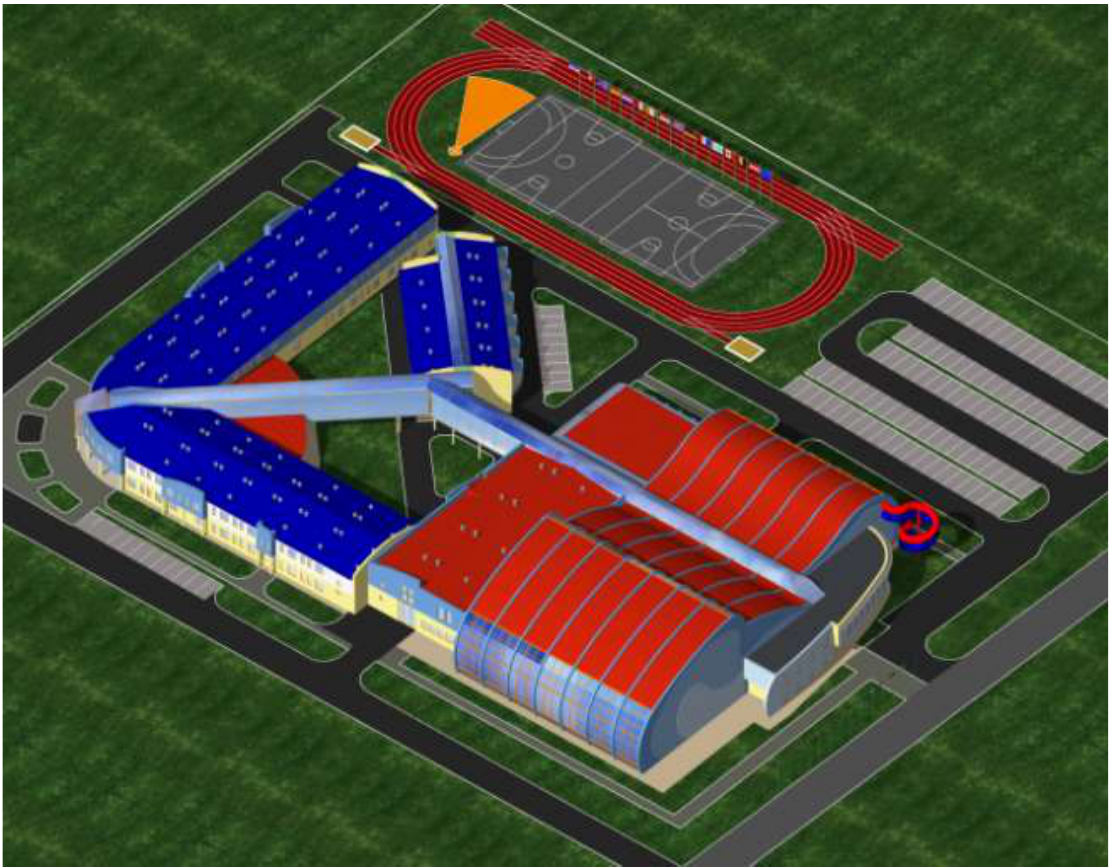
Figure 11. A view of the Integrated Didactic and Sports Center in Łomianki near Warsaw.